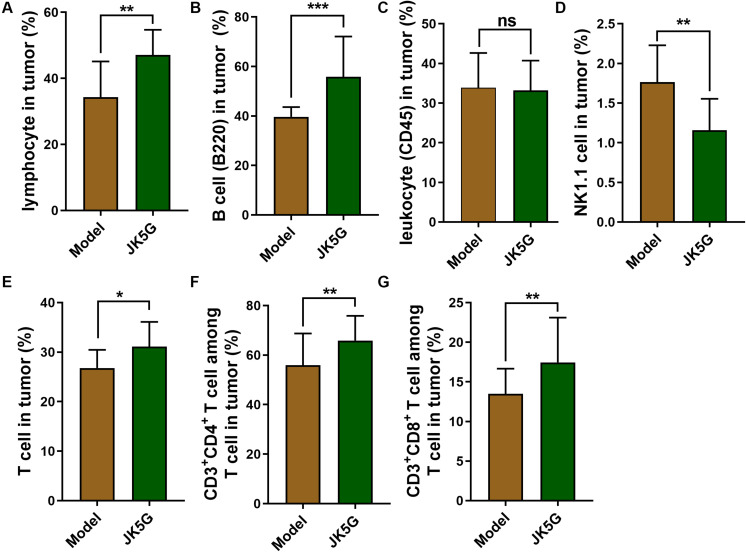
The comparison of proportions of lymphocytes (A), B cells (B), leukocyte (C), natural killer T cells (D), T cells (E), CD3+ CD4+T cells (F) and CD3+ CD8+T cells (G) between Model group and JK5G group in tumor. *p < 0.05; **p < 0.01; ***p < 0.001.